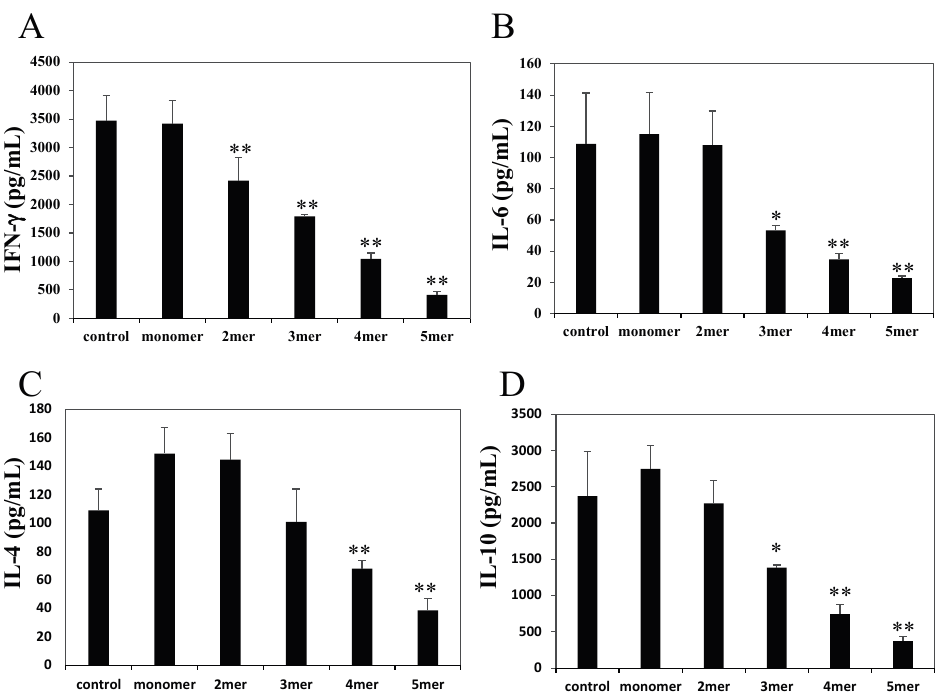
Figure 4. Effects of oligomeric procyanidins on the production of the effector cytokines, interferon (IFN)- γ ( A ), interleukin (IL)-6 ( B ); IL-4 ( C ); and IL-10 ( D ) by activated CD4 + T cells. Splenic CD4 + T cells were stimulated with an anti-CD3 ε monoclonal antibody in the presence of oligomeric procyanidins (25 μ M). The data shown are the means ± SD